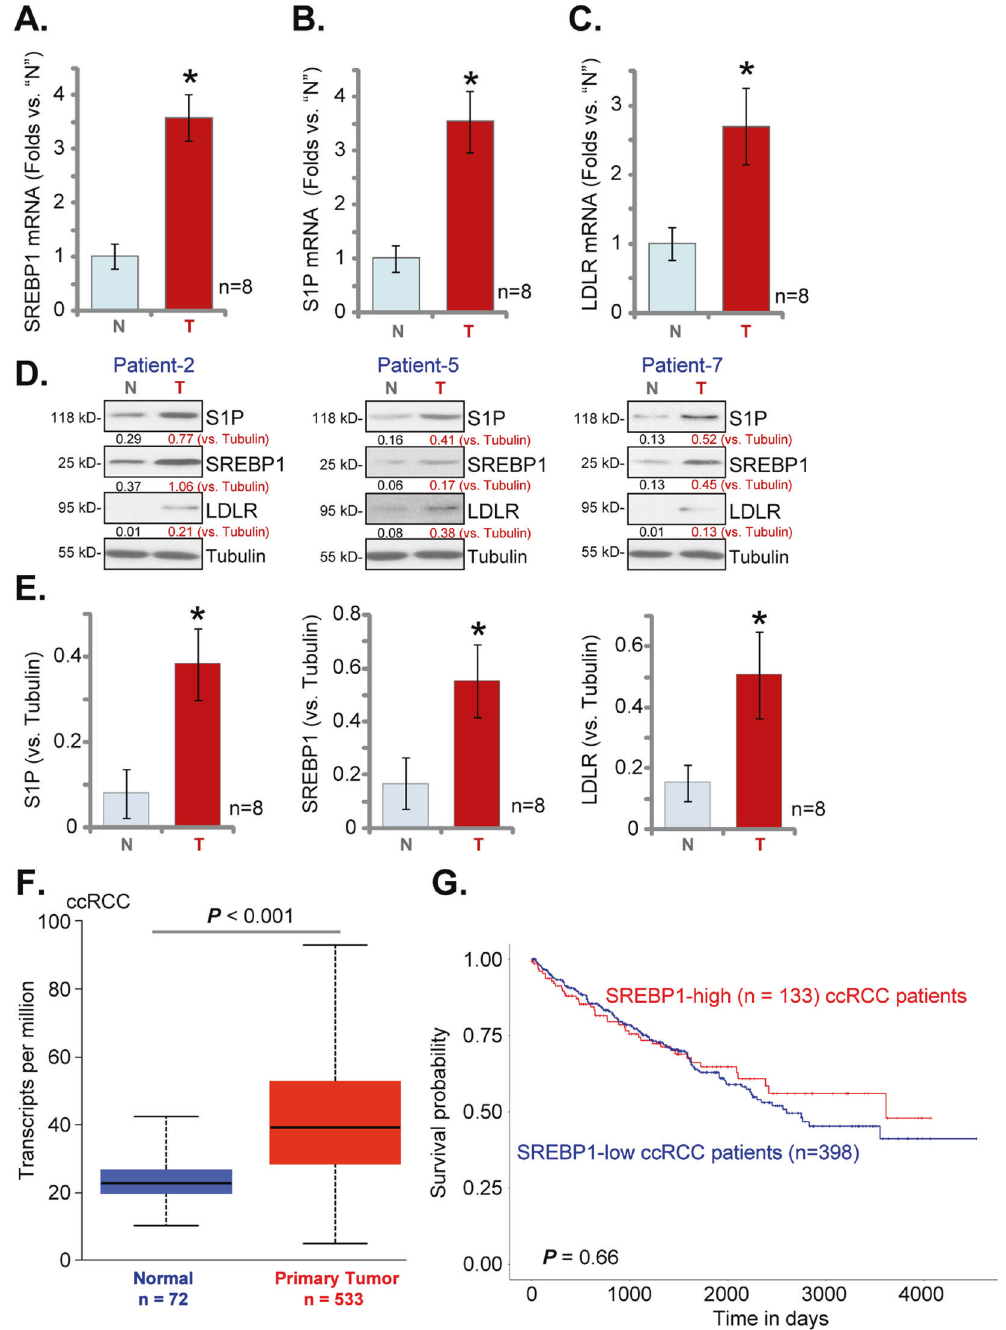
Fig. 6 SREBP1-S1P upregulation in human RCC. Eight ( n = 8) pairs of human RCC tumor tissues ( “ T ” ) and surrounding normal renal tissues ( “ N ” ) were obtained, expression of listed genes was tested by RT-qPCR ( A - C ) and Western blotting ( D , E ) analyses, results were normalized and quanti fi ed. The TCGA cohort shows relative SREBP1 transcripts in 533 cases of ccRCC tissues ( “ Primary Tumor ” ) and 72 cases of normal renal tissues ( “ Normal ” ) ( F ). Kaplan – Meier Survival analyses of SREBP1 -low ( n = 398, in blue) and SREBP1 -high ( n = 133, in red) ccRCC patients were shown ( G ). Data were expressed as the mean ± standard deviation (SD). * P < 0.05 vs. “ N ”